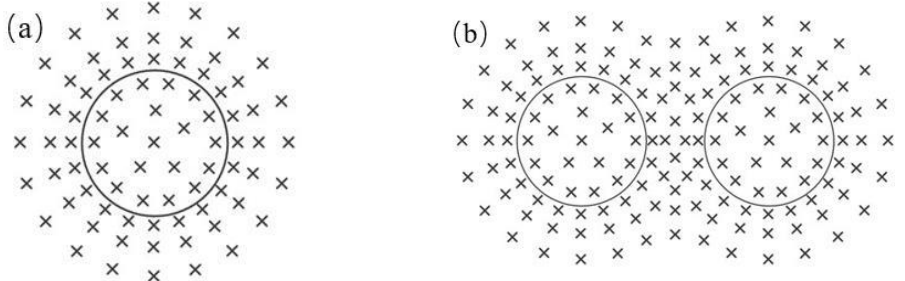
Figure 4. Distribution of magnetic lines at the poles. ( a ) Single combined bar magnet; ( b ) two combined bar magnets are parallel to the same pole.